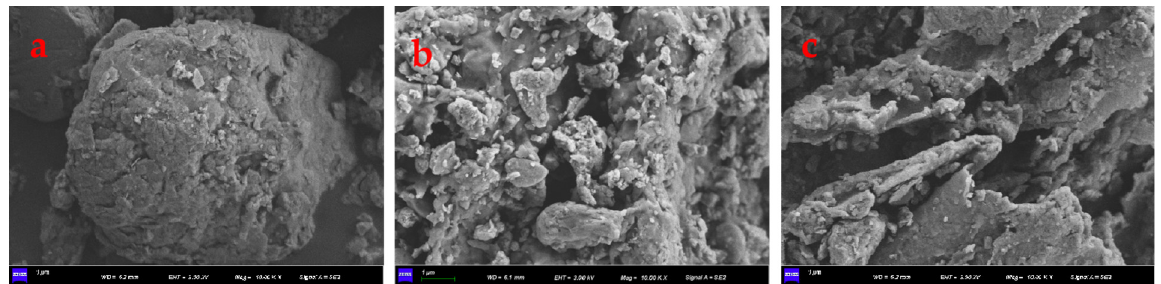
Figure 2. Scanning electron micrographs (SEM) images of pig ( a ), chicken ( b ) and cattle ( c ) manures with magnified 10.00 kx. Table 2. Effects of different N fertilizers on summer maize grain yield and total dry